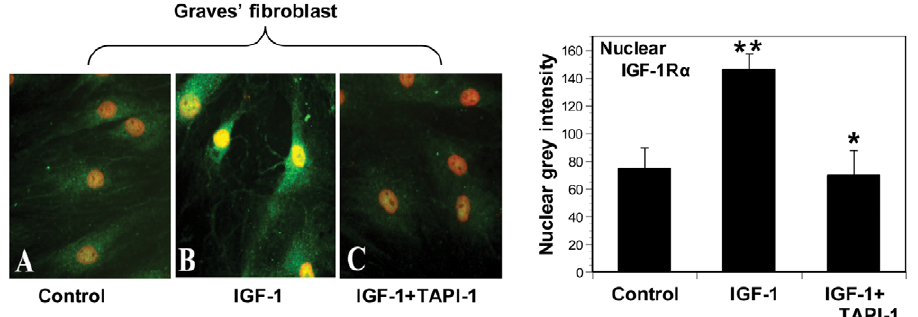
Figure 4. ADAM 17 appears to play a critical role in nuclear accumulation of IGF-1R a . ( A ) GD orbital fibroblasts express ADAM 17 protein as assessed by Western blot. ( B ). TAPI-1, a specific inhibitor of ADAM17 activity, blocks the nuclear accumulation of IGF-1R a provoked by IGF-1 in GD orbital fibroblasts. ( C ) Quantification of nuclear grey color signal intensity. Each bar in the histogram represents the mean 6 SD of ten nuclei randomly chosen for each treatment group. *, p , 0.05 vs IGF-1; **, p , 0.01 vs control, n=3 independent